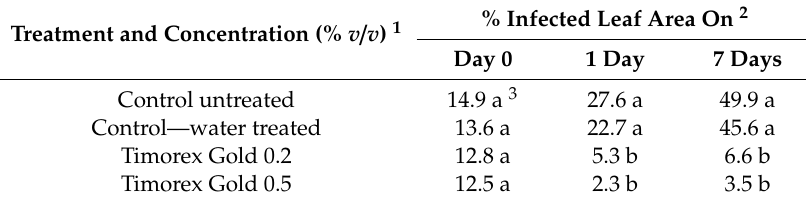
Figure 5. Suppression of powdery mildew colonies on cucumber leaf at one day post a single application of 0.5% Timorex Gold (right) or on a control untreated leaf (left). Note the disappearance of colonies on the surface of the treated leaf. Table 2. Suppression of powdery mildew on cucumber plants by a single foliar Timorex Gold spray.